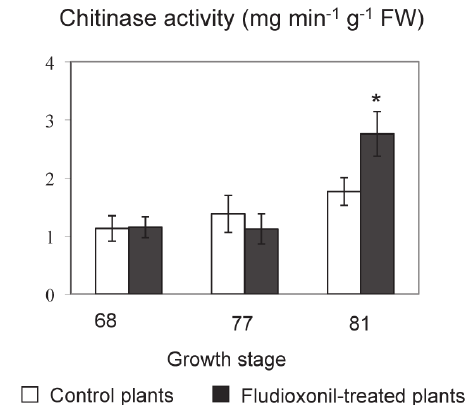
Figure 2. Mean chitinase activity in control and fludioxonil-treated flowers (BBCH stage 68) or berries (BBCH stages 77 and 81) of grapevine, 4 days after treatment. Data are means ± standard errors (n = 16). asterisks indicate signifi- cant differences ( P <0.05) between control and treated plants, as determined by the Student’s t